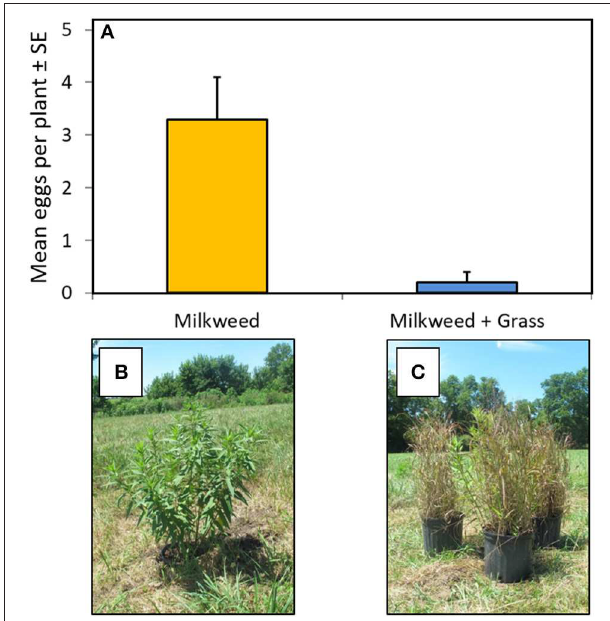
FIGURE 5 | (A) Abundance of monarch eggs observed on isolated milkweed plants and milkweeds visually obstructed by ornamental grasses. (B) Isolated potted milkweed set at ground level. (C) Milkweed visually obstructed by ornamental grasses. Means for isolated vs. obstructed plants differ significantly [ F (1,5) = 17.87, P <